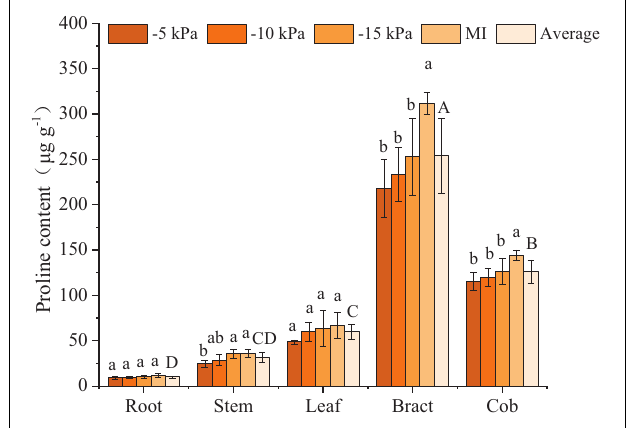
FIGURE 2 | Proline content in different organs of maize under different treatments. Values represent mean ± SD. The least significant difference (LSD) method was used to test differences among treatments or organs at the P < 0.05 level. Different lowercase letters indicate significant differences among treatments within the same organ, and different capital letters on the average value of all treatments in each organ indicate significant differences among